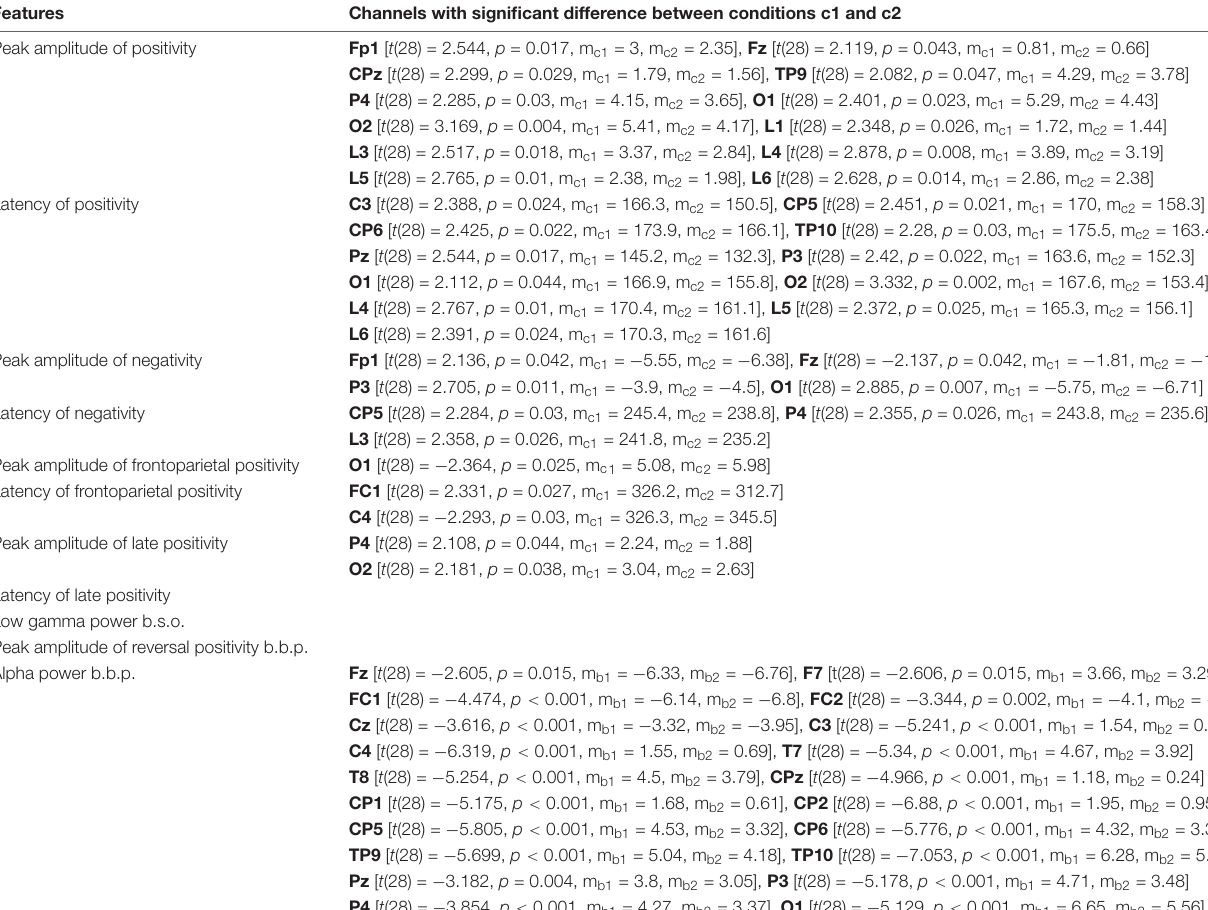
TABLE 2 | Channels that showed significant difference between conditions c1 and c2, for all